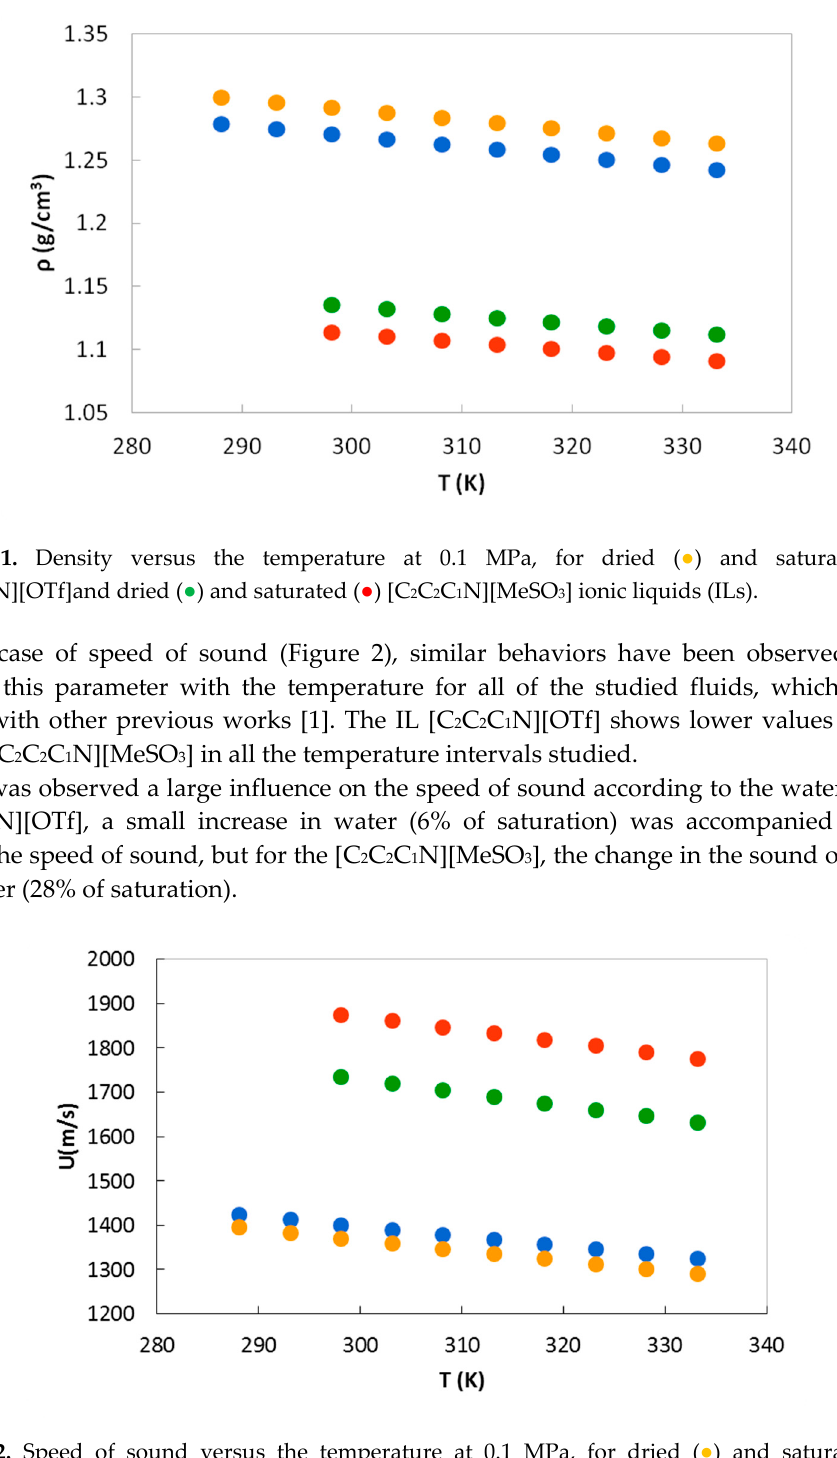
Figure 2. Speed of sound versus the temperature at 0.1 MPa, for dried ( ● ) and saturated ( ● ) [C 2 C 2 C 1 N][OTf] and for dried ( ● ) and saturated ( ● ) [C 2 C 2 C 1 N][MeSO 3 ]